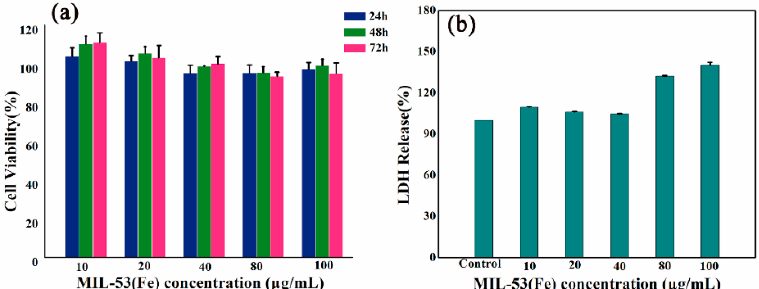
Figure 7. Effects of MIL-53(Fe) on cell viability and morphology. ( a ) MTT assay data were presented as mean ± SD of viability % of three independent experiments. ( b ) Evaluate HepG2 cells nuclear morphology by DAPI staining. Molecules 2018 , 23 , x